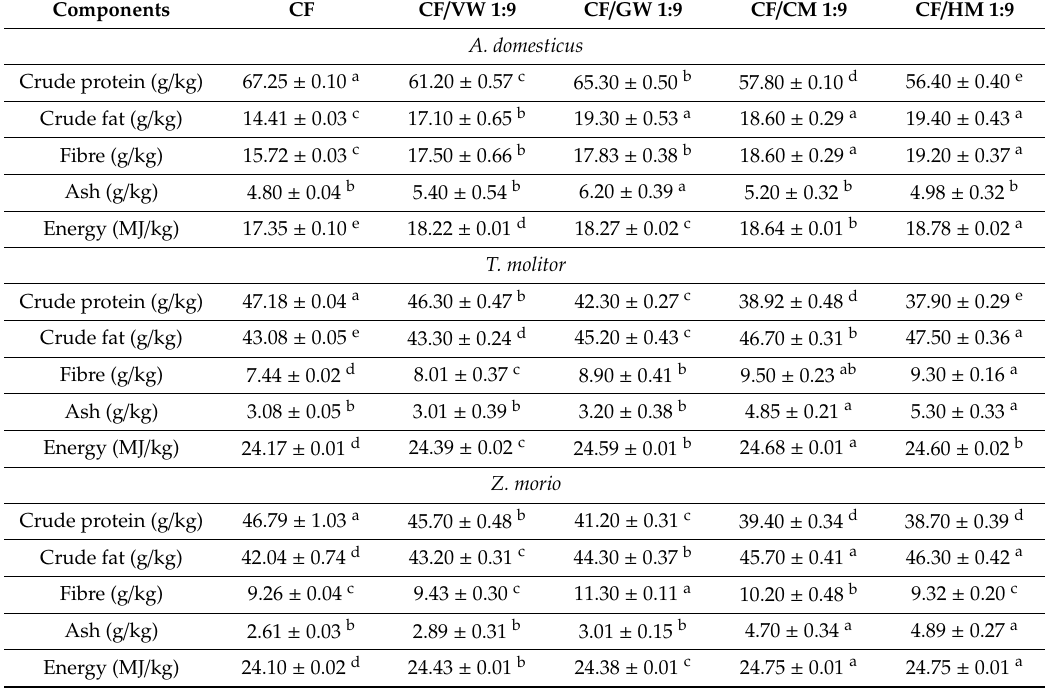
Table 3. Analysed nutrient composition of Zophobas morio , Tenebrio molitor , and Acheta domesticus larvae by diet (the values are presented as mean ± SD in dry weight %, n =